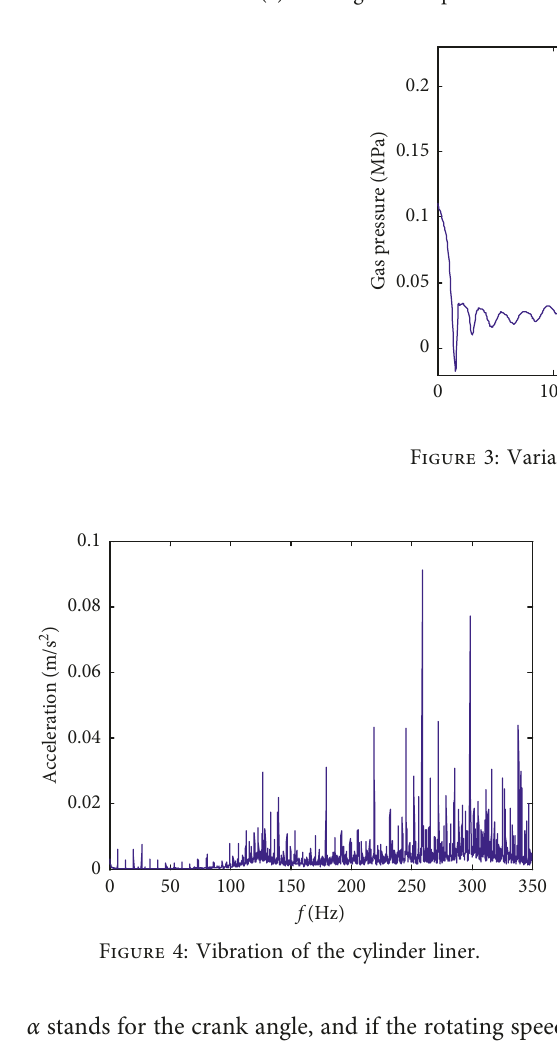
Figure 2: (a) Raw signal for speed measurement. (b) The measured instantaneous angular speed.